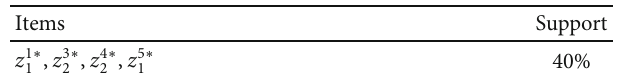
Table 11: Frequent item set L